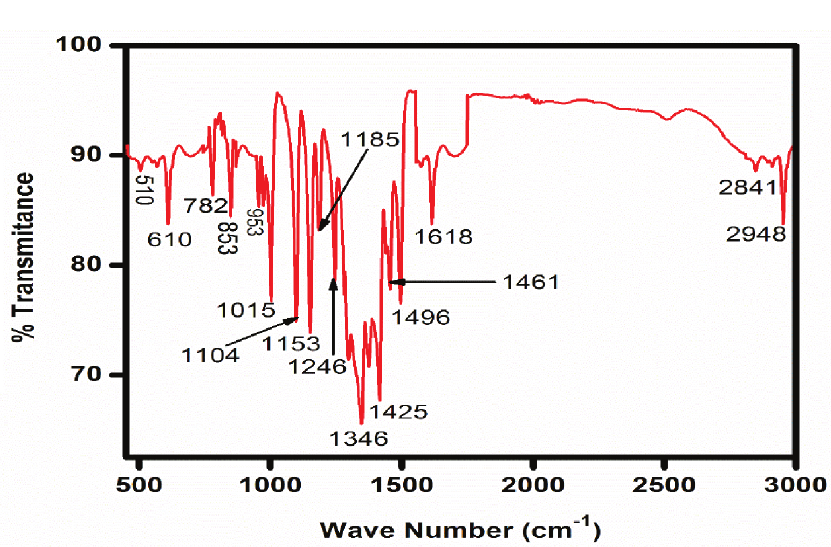
Figure A4: Raman spectra of (a) CIS and (b) CZS-ZS thin films.